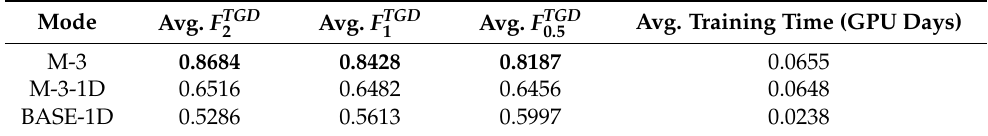
Table 5. Model performance evaluation results of 1D